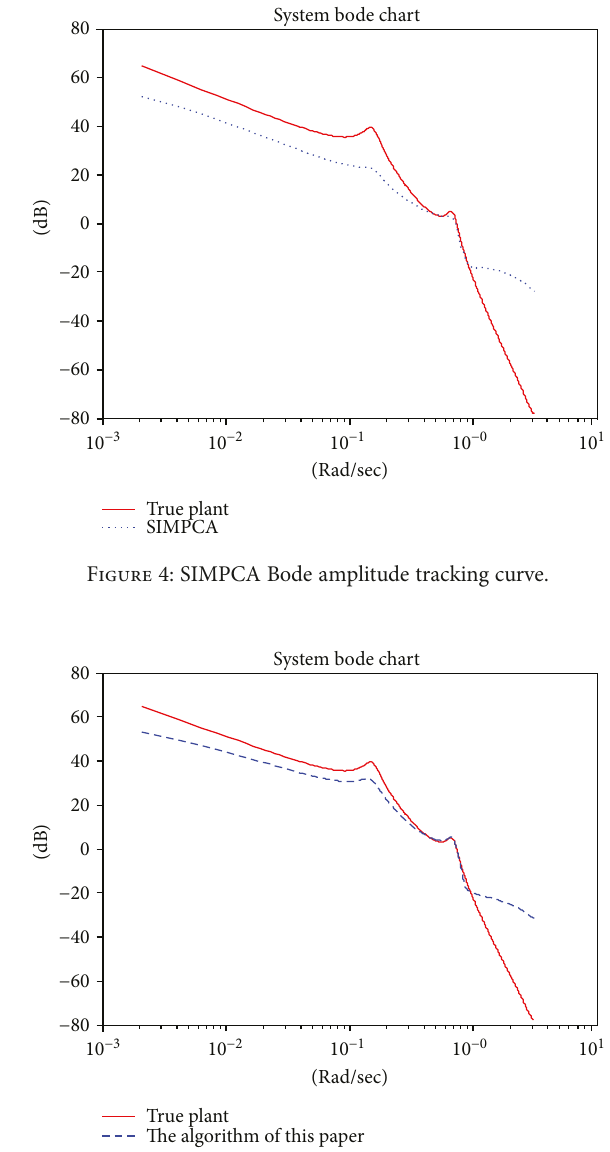
Figure 5: The algorithm of this paper Bode amplitude tracking